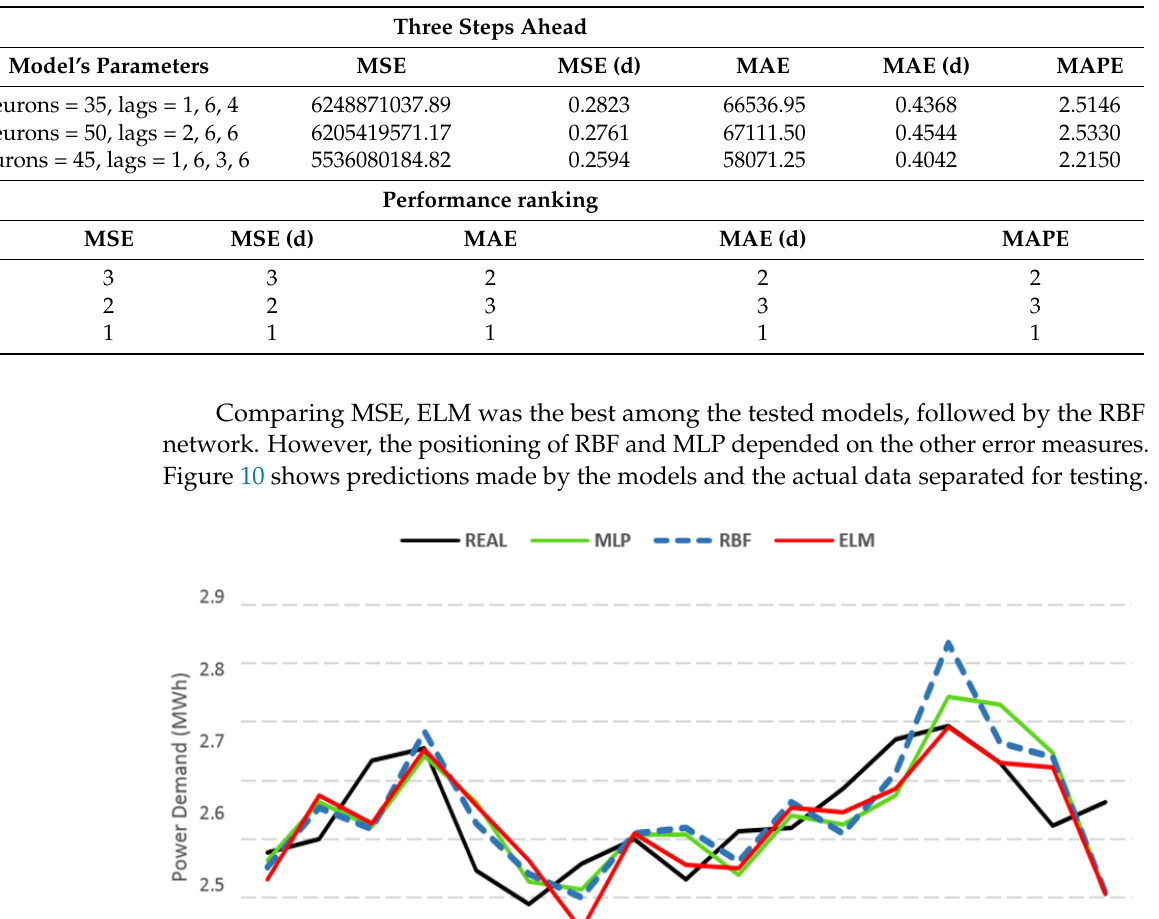
Table 18. Forecast results for three steps ahead, compared by the error measures MSE, MAE, MAPE, and their respective performance rankings.